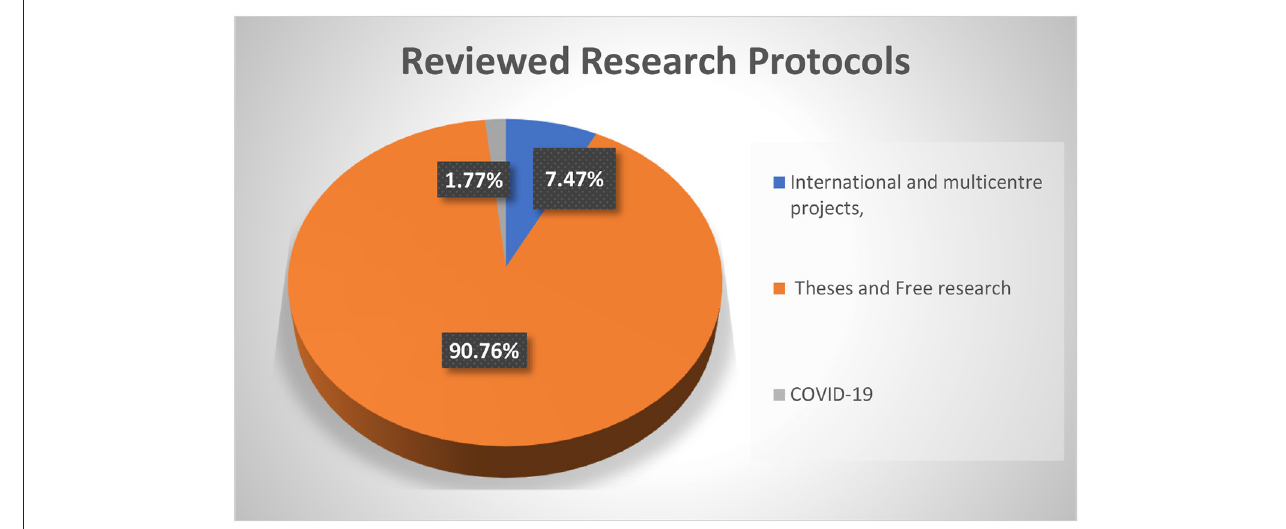
FIGURE 1 | FMASU REC Workload from January 1st, 2008 to October 13th,